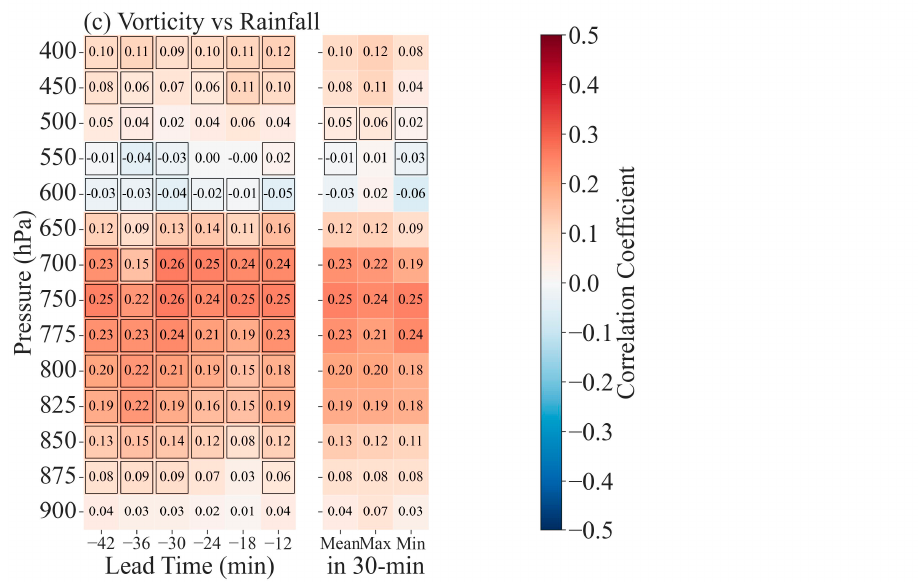
Figure 4. Time-lag correlation coefficients between rainfall intensity and ( a ) divergence, ( b ) vertical velocity, and ( c ) vorticity (at 10-min intervals) retrieved from the RWP mesonet within 30 min before the onset of rainfall ( − 42– − 12 min). The black solid grid points represent statistical significance passing the 99% confidence level.